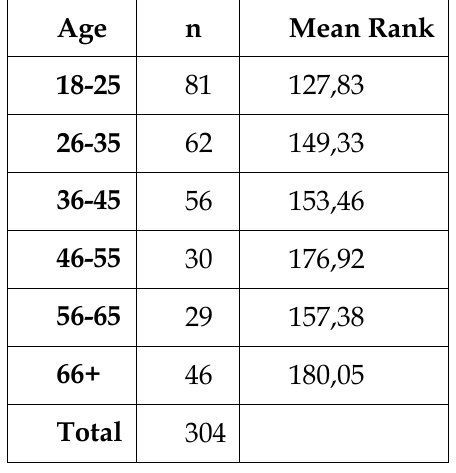
Figure 6. Trust towards the health centre and age. Percentage per reported value on scale 5-1. 18-25 years n=81 (100%), 26-35 years n=62 (100%), 36-45 years n=56 (100%), 46-55 years n=30 (100%), 56-65 years n=29 (100%), 66+ years n=46 (100%). Total n=304. Figure above indicates a difference between age categories regarding their trust towards the health centre. Older people seem to trust the health centre to a higher degree. Table 14. Trust towards the health centre and age. Kruskal-Wallis mean